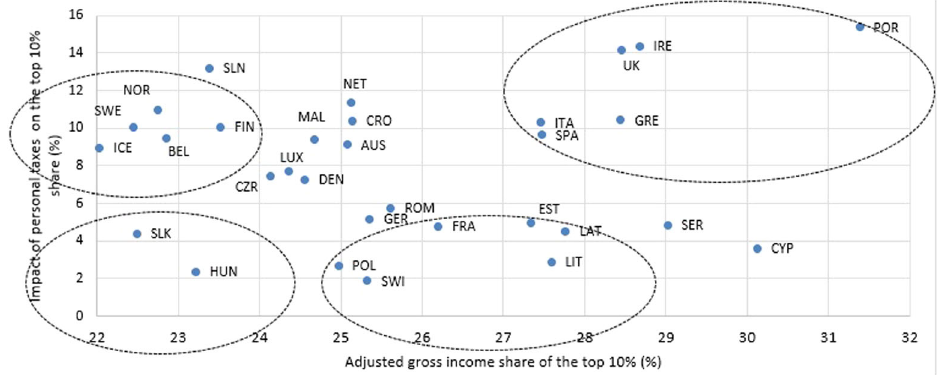
Fig. 3 Correlation between pre-tax income inequality and redistributive impact of taxes (top 10% shares), European countries (2013 – 2014) (%). Source: EU-SILC microdata 2014 and